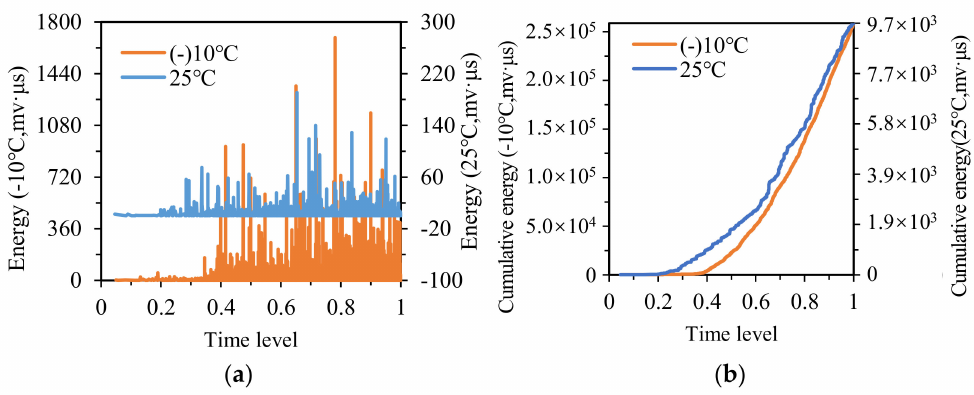
Figure 11. The energy and cumulative energy distribution of SMA at − 10 ◦ C and 25 ◦ C: ( a ) energy; ( b ) cumulative